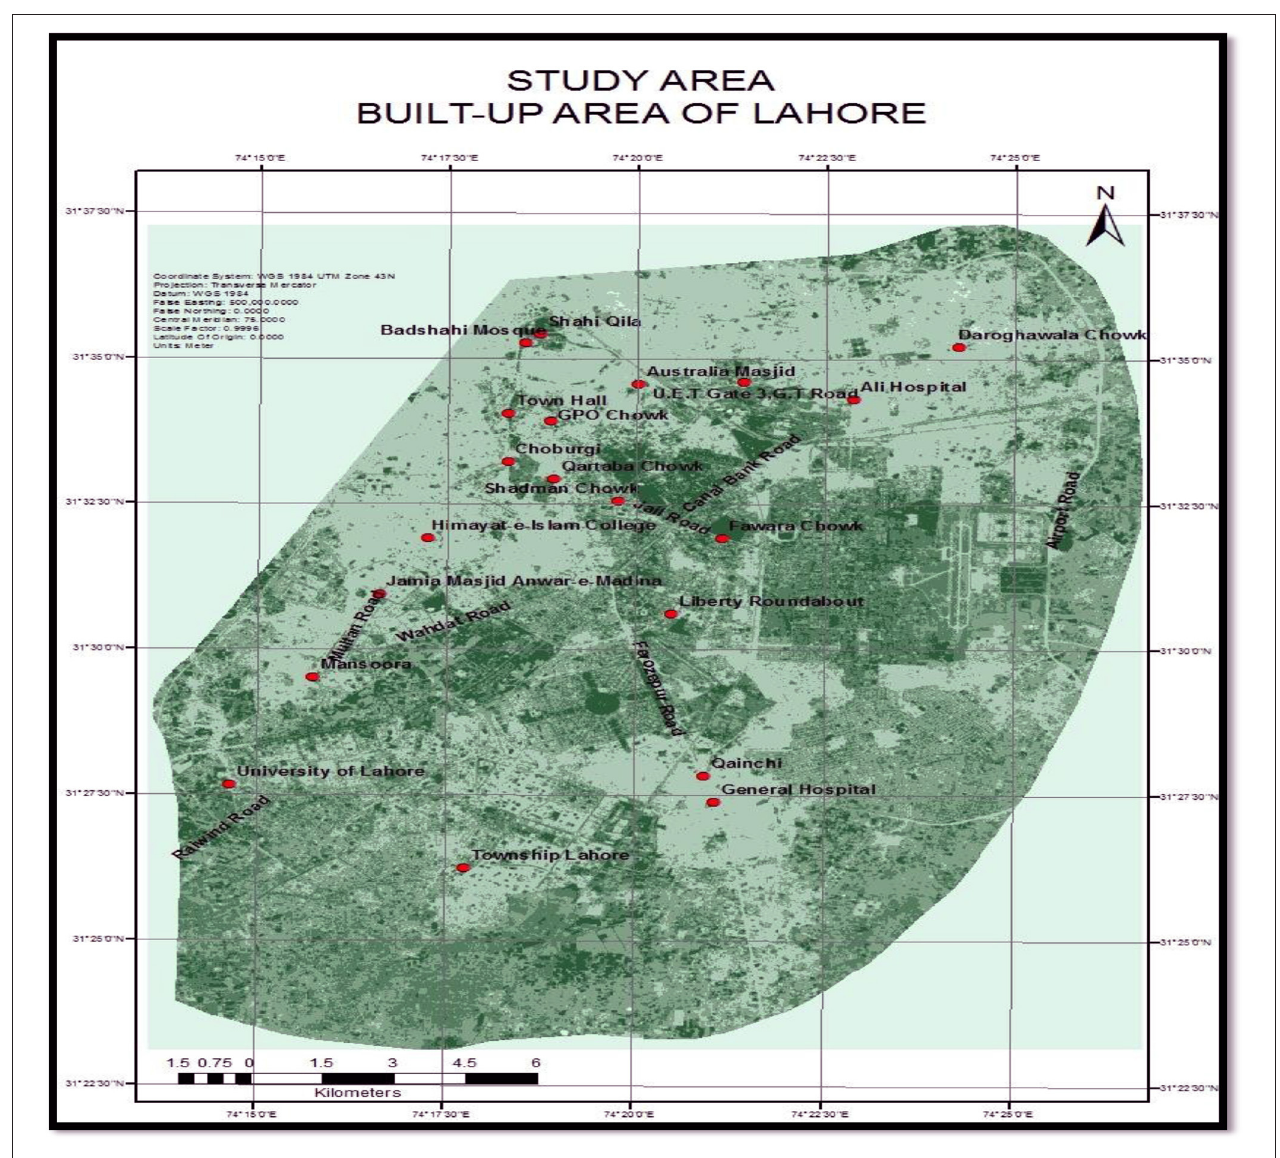
FIGURE 1 | Base map of the case study area, Lahore. Source: by